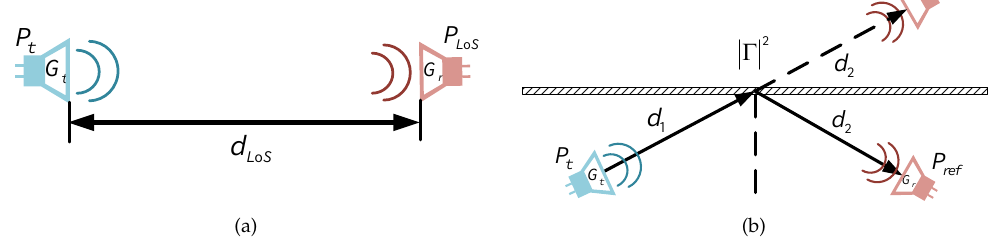
Figure 1. Transmission in free space. ( a ) LoS propagation measurement, ( b ) Reflection